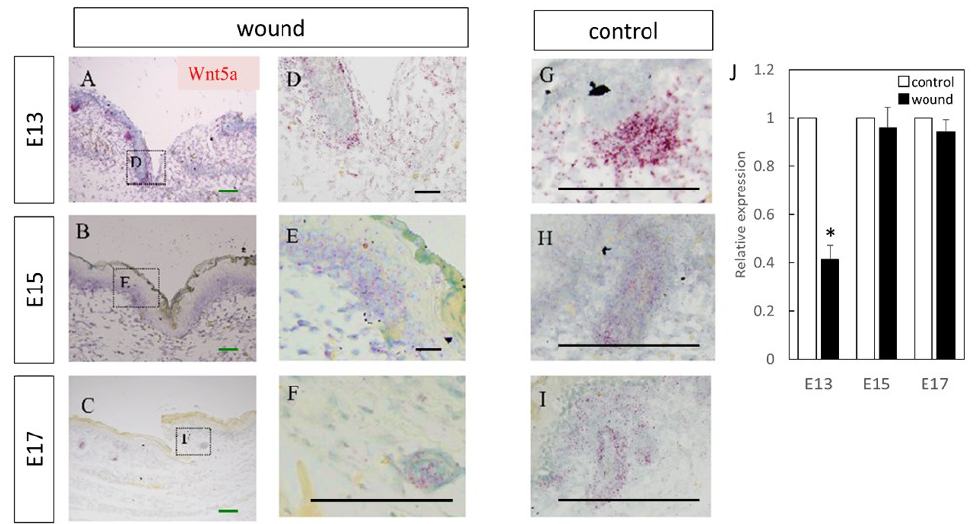
Figure 2. Measurement of Wnt5a expression in wound by in-situ hybridization and real-time quan- titative PCR. Wnt5a expression is indicated in red in the tissue. Wnt5a was specifically expressed in the dermal layer around the epidermal-dermal junction and around hair follicles. ( A – C ) Weakly magnified images of the region around the wound. ( D – F ) Strongly magnified images of the wound margin. ( G – I ) Observed images of the normal area. ( J ) Decreased expression of Wnt5a at the wound site on E13. * p < 0.05. ( A – C ) Scale bar = 200 µ m. ( D – I ) Scale bar = 100 µ